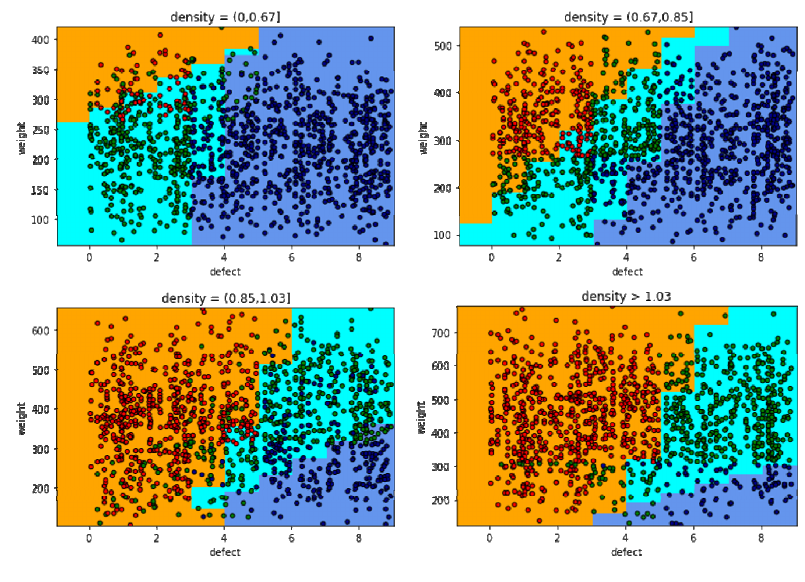
Figure 21. Classification of SVM model.